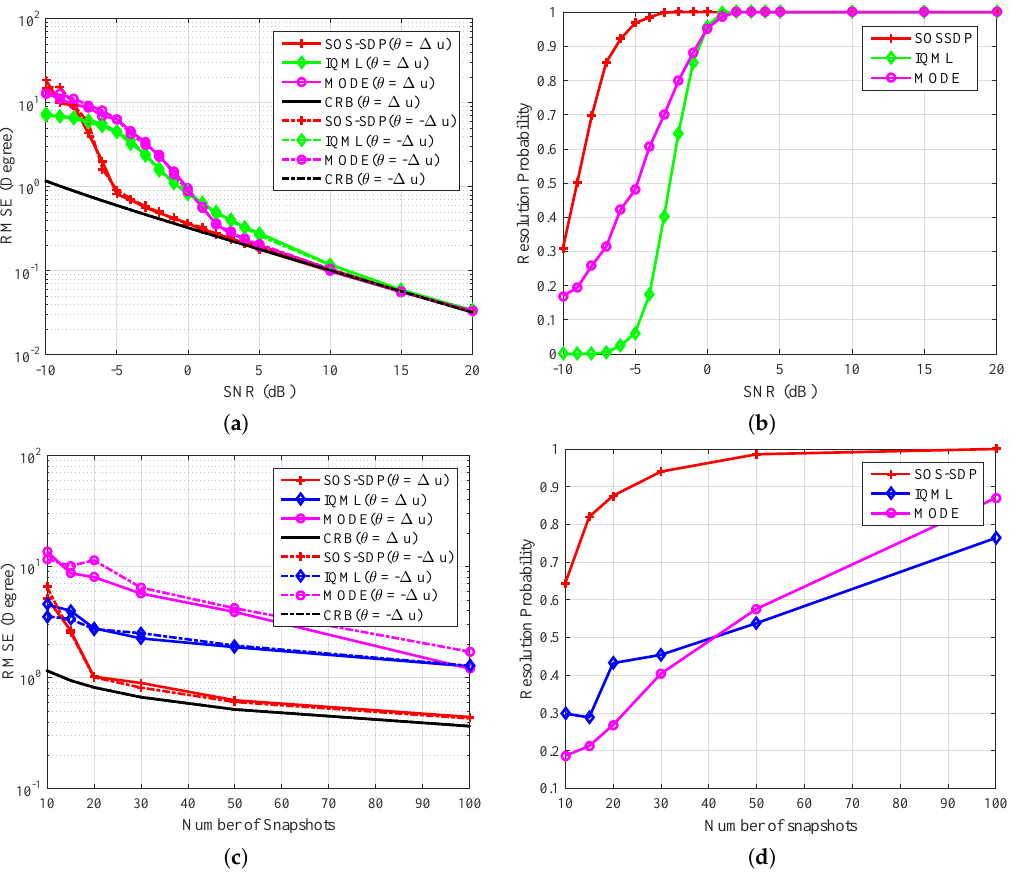
Figure 2. Comparisons of RMSE and resolution probability of different methods for two equal power coherent sources. Other settings include: θ = [ ∆ u , − ∆ u ] and ULA with N = 12. ( a ) RMSE versus SNR with N t = 100; ( b ) resolution probability versus SNR with N t = 100; ( c ) RMSE versus the number of snapshots with SNR = 0 dB; and ( d ) resolution probability versus the number of snapshots with SNR = 0